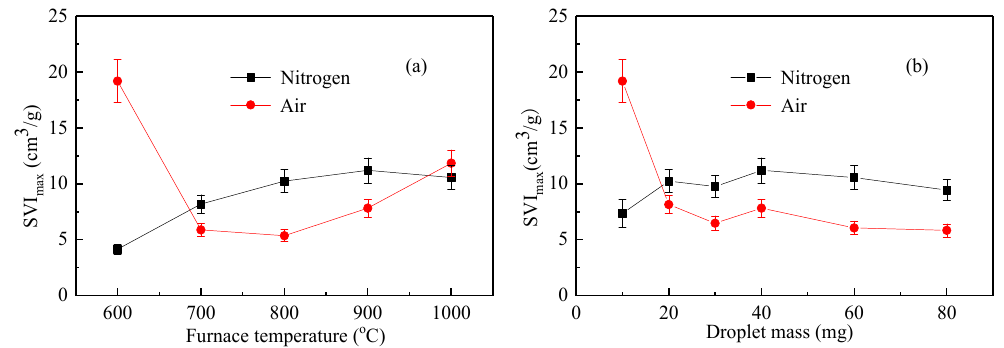
Figure 8. The maximum swelling volume index (SVI max ) of the waste liquor in the vertical tube furnace: ( a ) SVI max with furnace temperature; ( b ) SVI max with droplet mass.